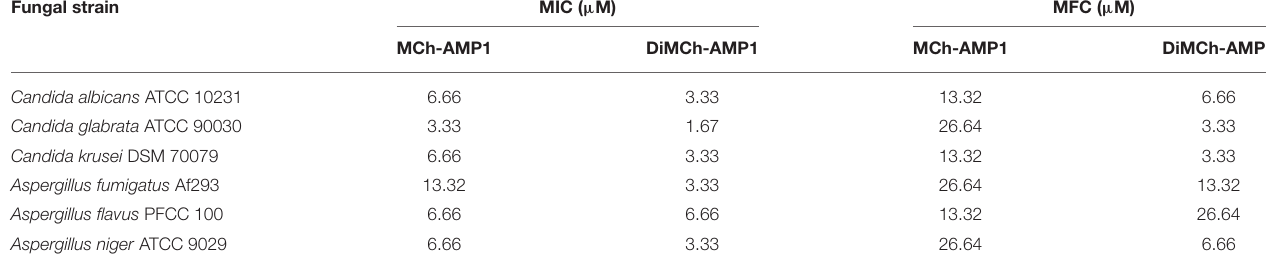
TABLE 2 | The MIC and MFC values of MCh-AMP1 and DiMCh-AMP1 for tested fungal strains. Fungal strain MIC ( µ M)